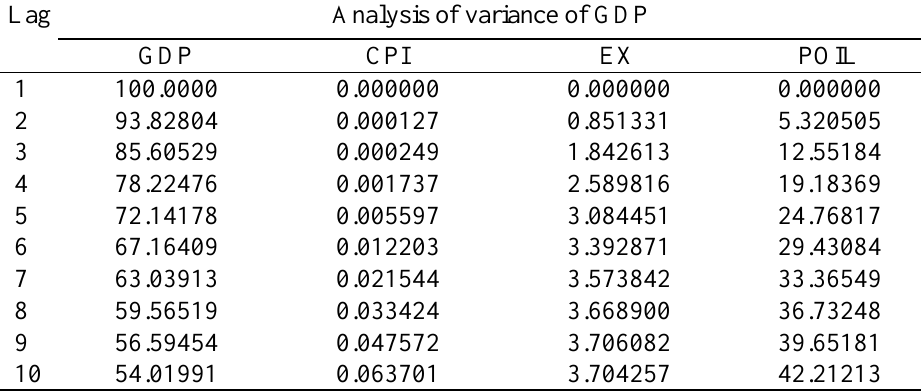
Table 6. Analysis of variance for